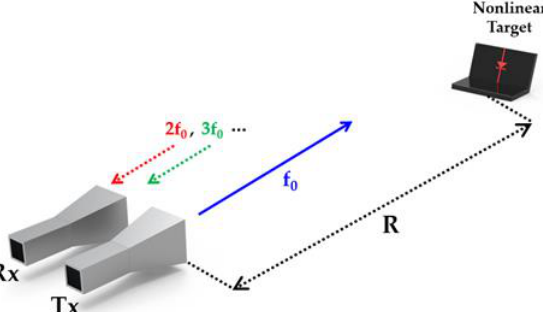
Figure 1. An illustration of a harmonic-based nonlinear detection. The first term in Equation (2) describes the transmitted power density incident at the target. The second term is the “apparent RCS” which refers to the apparent size of the target that is perceived by the radar [30]. Note that σ is changed to σ (cid:48) to indicate the apparent RCS. The third term represents the free space spreading loss. The last term describes the effective aperture of the Rx antenna. Hence, the total received power P r is the product of the abovementioned terms.